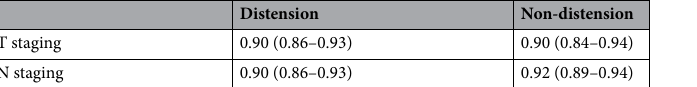
Diagnostic performance. Interrater reliability for the independent readers is shown in Table 2. In both Distension and Nondistension groups, the ICC was good to excellent for T and N staging, indicating that readers had a high degree of agreement. Table 3 tabulates the T and N staging performance metrics of Distension and Nondistension groups derived from consensus reading. The overall accuracy of Distension versus Nondistension groups in T staging was 45% (95% CI 35–56) and 55% (95% CI 44–65), respectively ( p = 0.29), and there was no difference in the overall accuracy for N staging in either group (51% [95% CI 40–62] in both). There were no significant differences in sensitivity and specificity of individual T and N staging between Distension and Nondistension group. Figure 1 shows clinical case examples of T1 to T4b staging cancers in Distention and Nondistention groups. Table 4 compares the diagnostic performance for assessing serosal invasion in Distension and Nondisten- sion groups. The sensitivity was greater than 90%, and the positive predictive value greater than 80% in both groups. However, no significant difference in diagnostic performance was demonstrated between Distension and Nondistension groups. Discrepancies in clinical and pathological TN staging are shown in Table 5. Concordant staging for T2, T3, T4a and T4b was 60%, 59%, 33% and 50%, respectively, for the Distension group and 67%, 58%, 43%, 80%, respectively, for the Nondistension group. In overstaged pT1 lesions, 24% (5/21) in Distension group and 42% (5/12) in Nondistension group were overstaged by two levels ( p = 0.48). There was no significant difference in